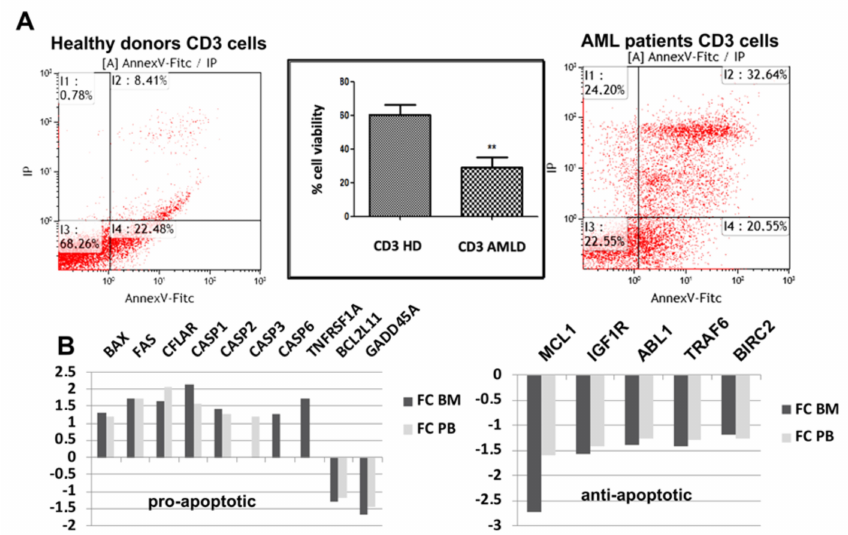
Figure 1. Fragility measurement of AML T lymphocytes. ( A ) The viability percentage of isolated and activated T lymphocytes (PHA / IL2) was measured in HD and untreated AML patients ( = 7) within six days post culture using an apoptosis test (cells were labeled with annexin-V-FITC and PI). The level of statistical significance was set at p < 0.01 (**). ( B ) Relative expression of proapoptotic and antiapoptotic genes in AML T lymphocytes ( = 27) compared to cells from HDs ( = 11) in both bone marrow (BM) and peripheral blood (PB) samples as determined using A ff ymetrix microarray (fold change > 1.25 and p <